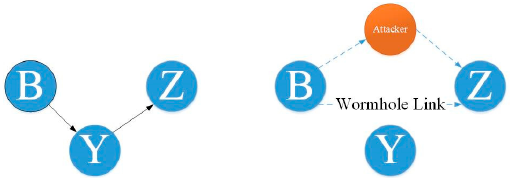
Figure 17. Wormhole attack on WSN [88,89].